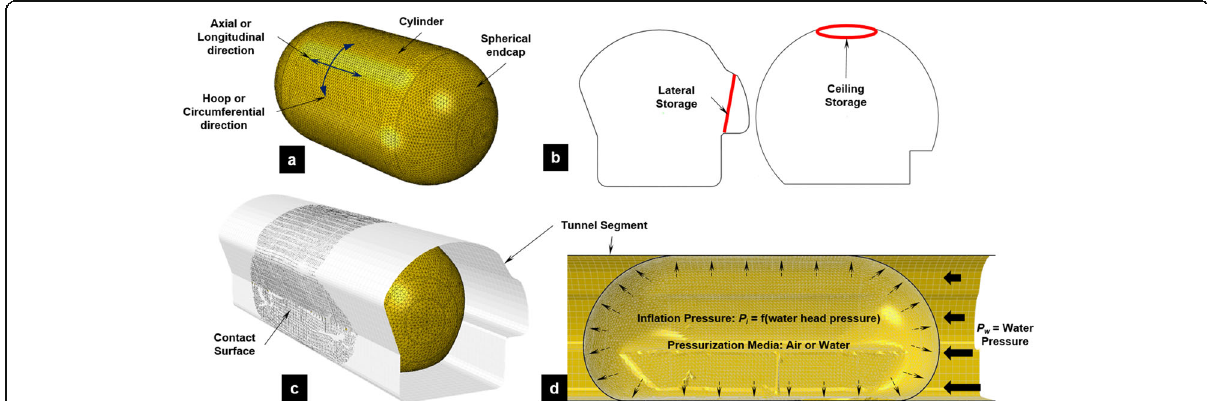
Fig. 1 A conceptual overview of the RTP System: a Inflatable plug, unconfined configuration; b Tunnel profiles and folded plug storage areas; c Inflatable plug deployed and inflated in the tunnel (confined configuration); d Longitudinal cross-section, inflation and flooding pressures [42 –